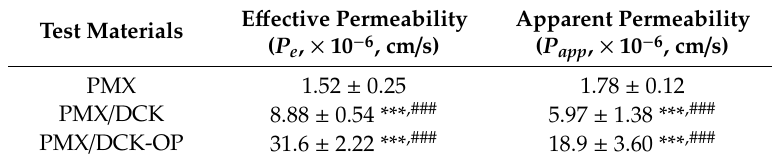
Table 1. E ff ective and apparent permeability of PMX, PMX / DCK, and PMX /